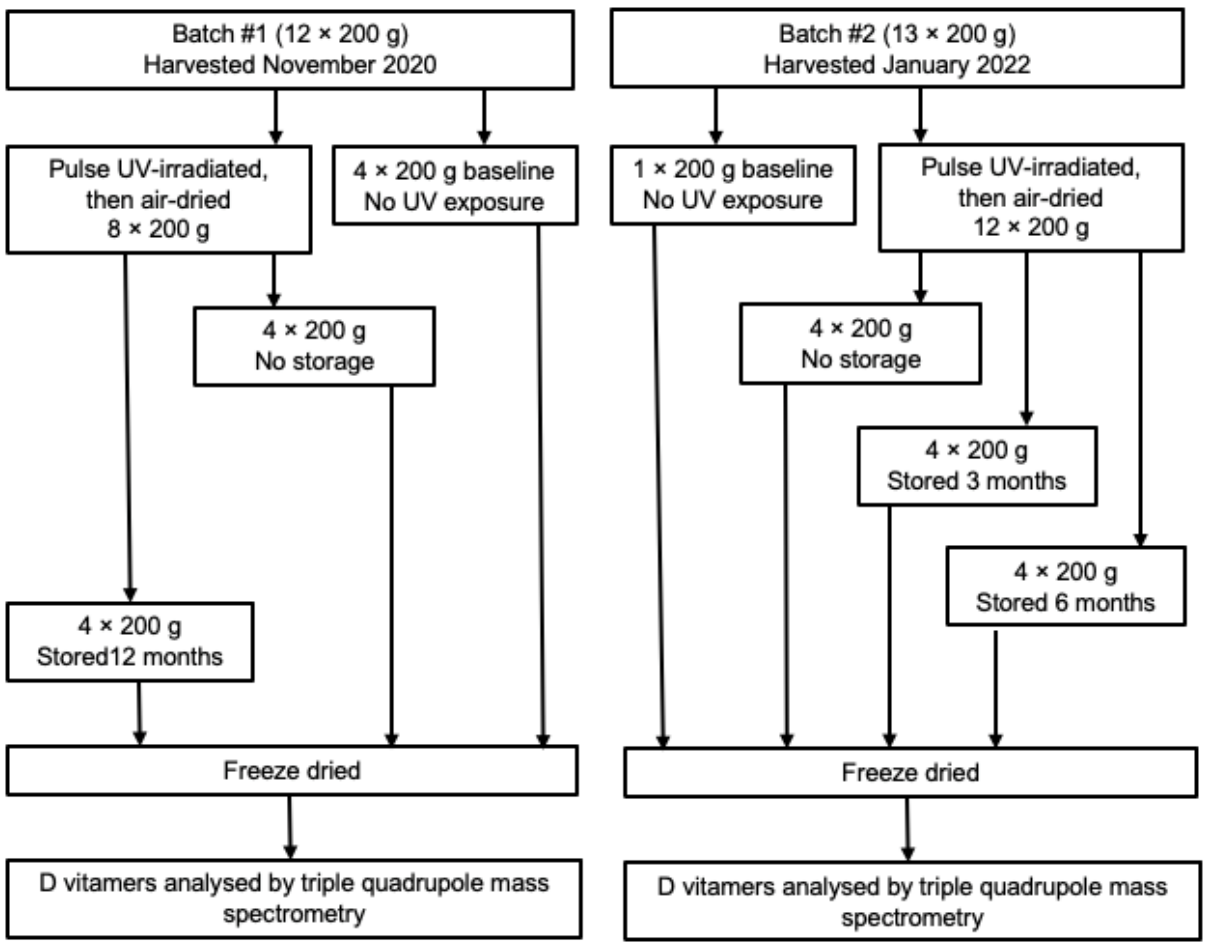
Figure 1. Schematic overview of UV-irradiating, drying and extracting D vitamers from button mushrooms.